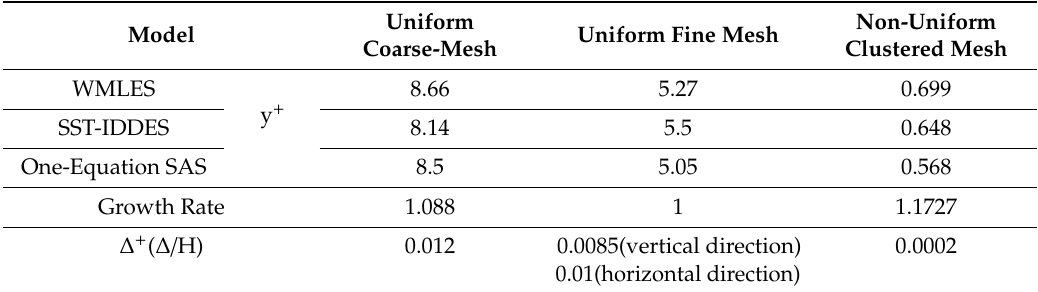
Table 2. Values of y + , ∆ + and growth rate for all models and grids used for the flow past an array of